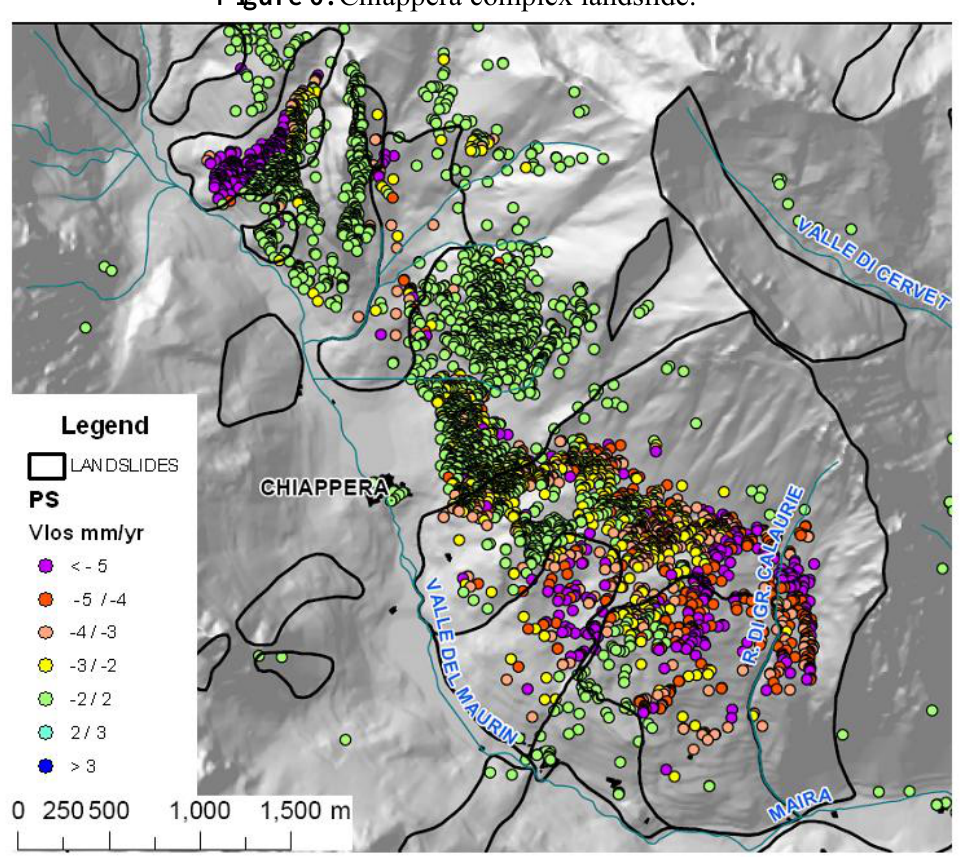
Figure 6. Chiappera complex